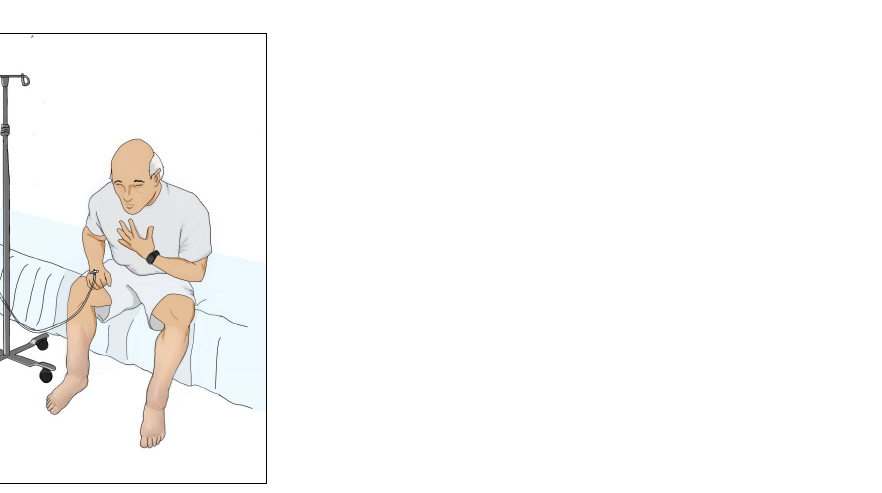
Figure 1. The photoplethysmography-based monitor in a wristwatch configuration. The device is shown to be worn by a heart failure patient while receiving intravenous diuretics. 2.5. Data Collection Physiological data were collected by the PPG-based monitors and automatically transmitted to a cloud-based data storage, with no personal identifiers or any other pro- tected health information (PHI) included. Unusual events were recorded in parallel by the research team. The devices did not provide real-time alerts, and the data were analyzed